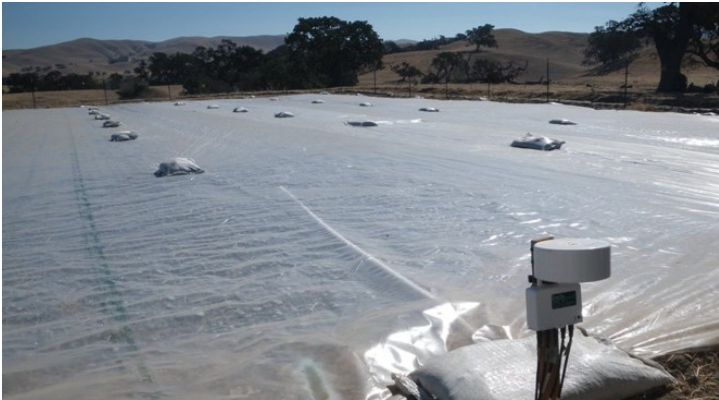
Figure 1. Solarization of a plant holding area near a large restoration planting where plants infected with Phytophthora tentaculata and other Phytophthora species were maintained for an extended period before planting. Soil temperature logger is at right. Credit: SFPUC.